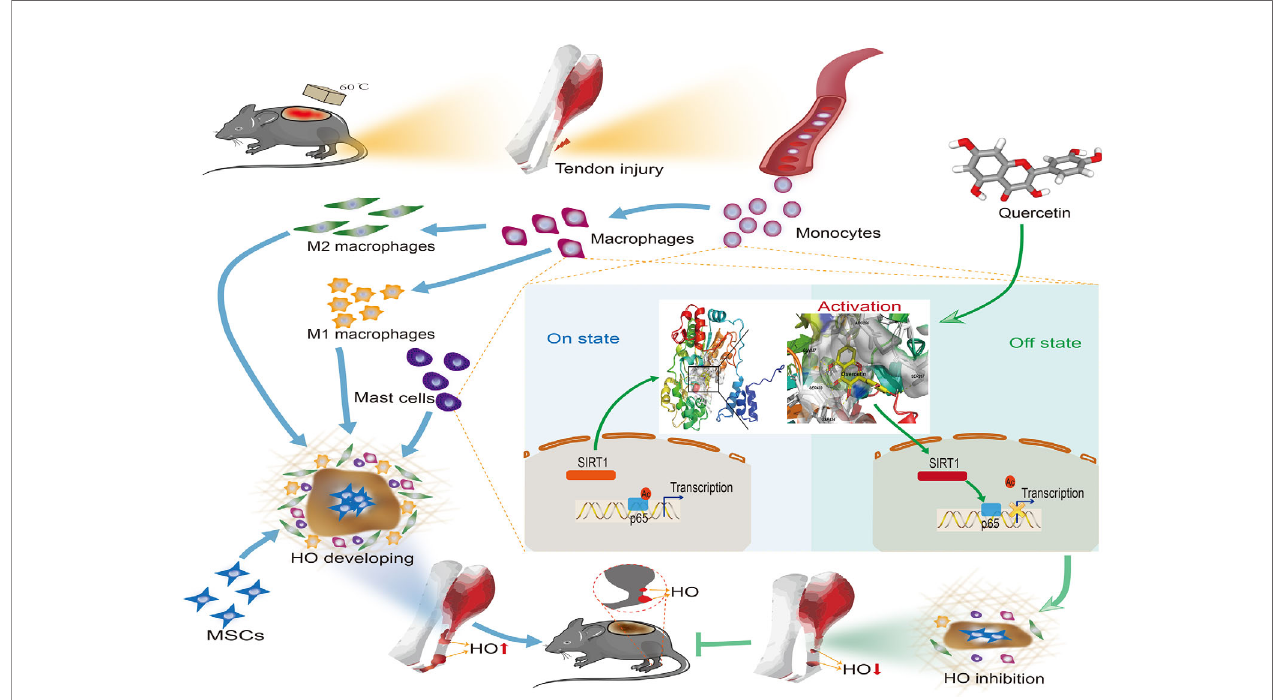
FIGURE 11 | Graphical summary of the effects and mechanisms of quercetin on immune responses that regulate HO progression. Upon tendon injury, monocytes are motivated by circulation and accumulate at the injury site where they undergo monocyte-to-macrophage transition and then are further polarized into the M1 and M2 phenotypes. In parallel, mast cells also respond to injury and in fi ltrate the injured tissue, synergizing with macrophages to constitute the osteogenic immune microenvironment, within which mesenchymal stem cells (MSCs) are recruited and induced osteochondral differentiation. However, quercetin suppresses the aforementioned monocyte-to-macrophage transition, macrophage polarization and mast cell activation partly by modulating SIRT1/NF k B signaling involved in these biological processes, thereby preventing HO